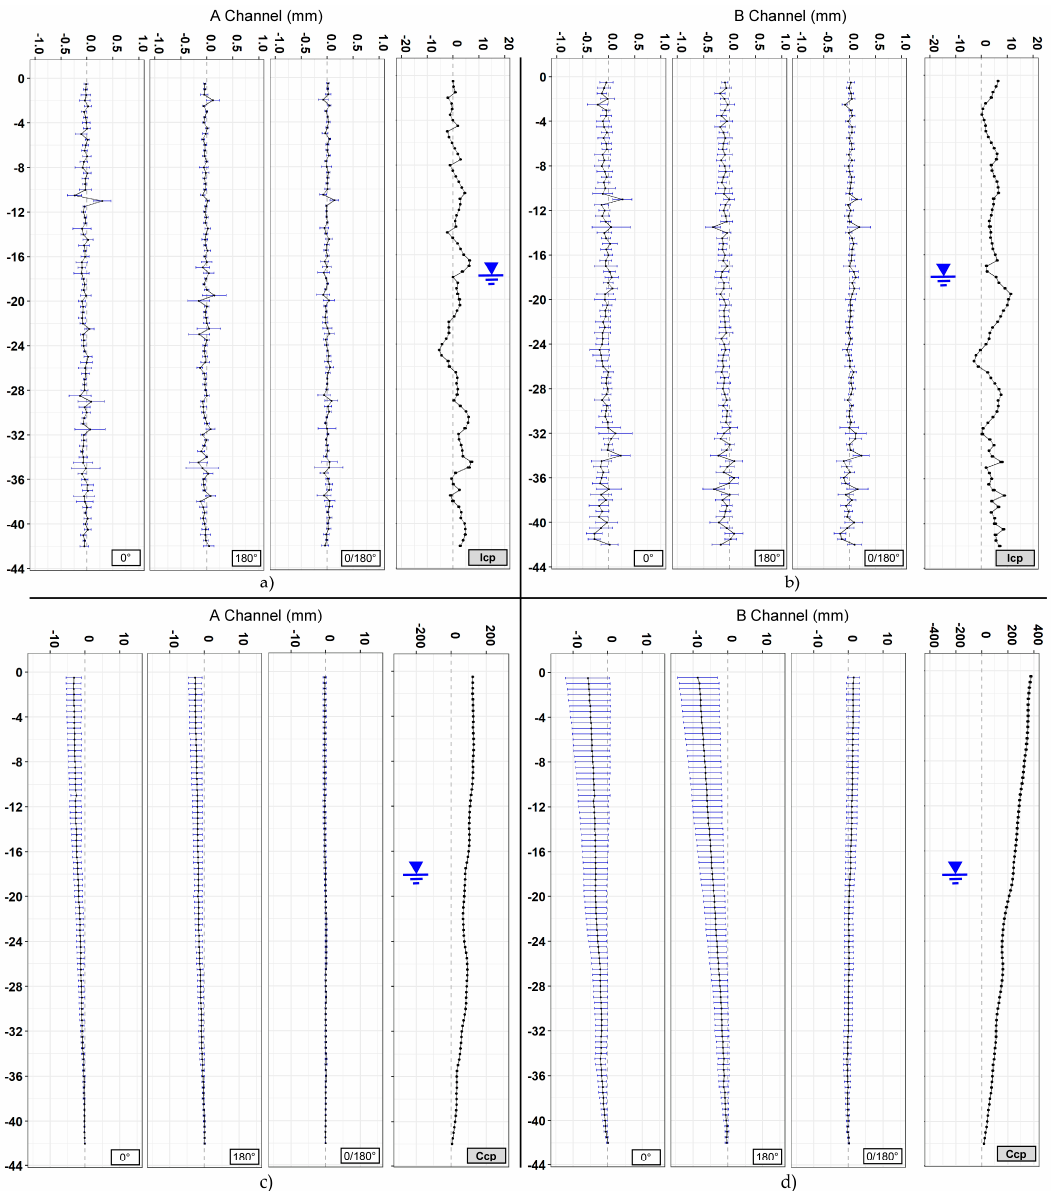
Figure 10. Section 2. ( a ) Incremental displacements for the A channel; ( b ) incremental displacements for the B channel; ( c ) cumulative displacements for the A channel; and ( d ) cumulative displacements for the B